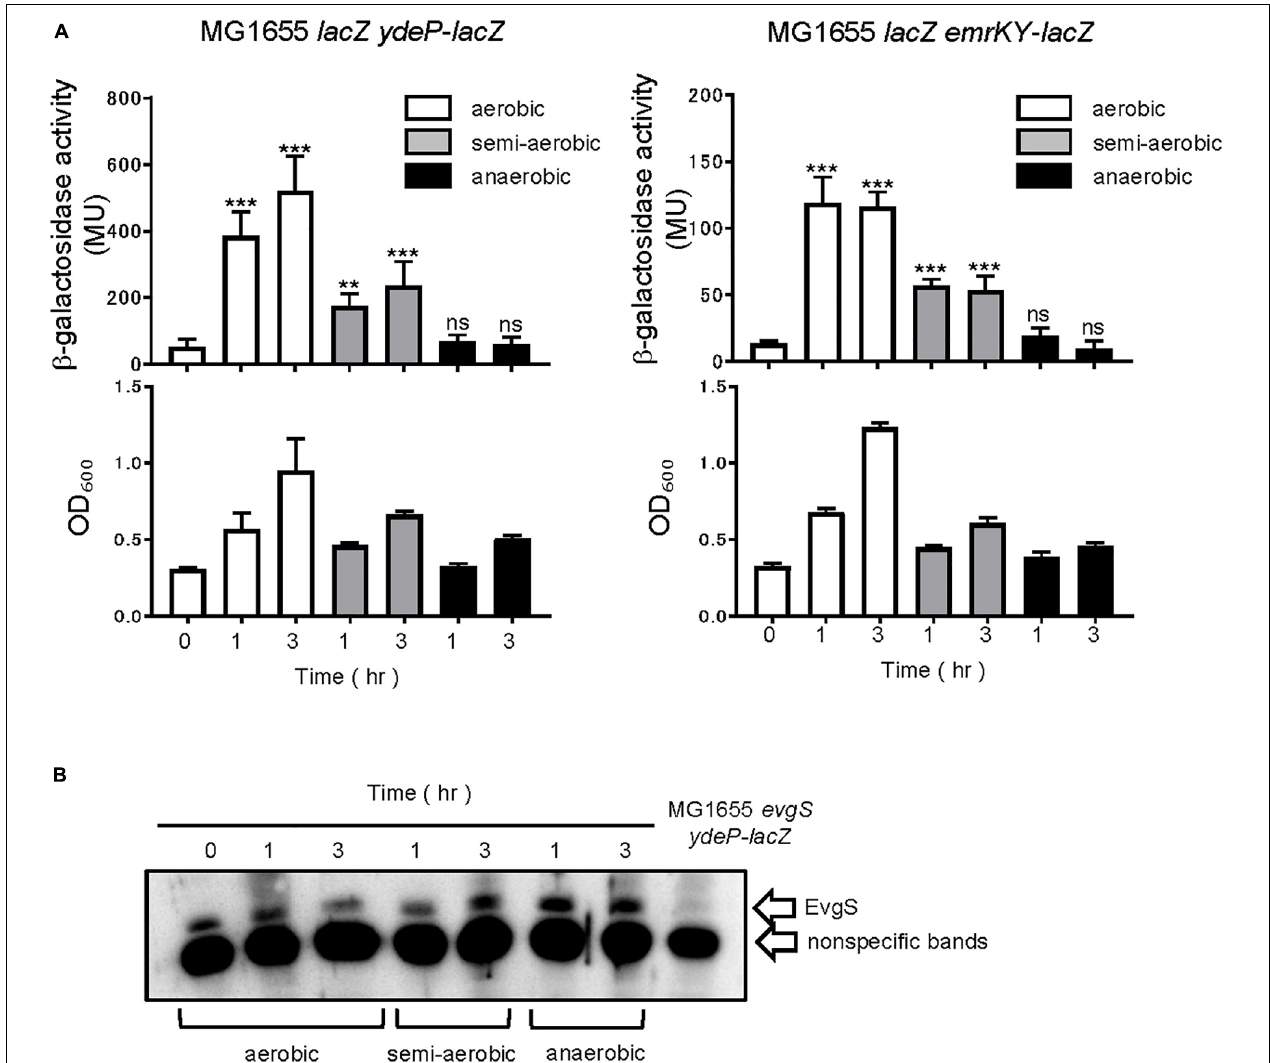
FIGURE 1 | Aeration is required for EvgS/EvgA activation. (A) Activity of the ydeP-lacZ and emrKY-lacZ reporters in different culturing conditions (upper panels). Cells were grown in EvgS-activation medium under aerobic (white bars), semi-aerobic (gray bars), or anaerobic condition (black bars) at 37 ◦ C. Cell growth indicated by optical density at 600 nm is shown in the lower panels. Data represent the average of three biologically independent replicates. Error bars indicate the standard deviation, and statistical analyses of each redox condition group were performed using Dunnett’s multiple comparison test with the time 0 sample as the control. ns, not significant; **0.001 ≤ p < 0.01; *** p < 0.001. (B) EvgS expression in MG1655 lacZ ydeP-lacZ . Immunoblotting analysis using anti-EvgS antiserum for EvgS detection is shown. Samples are from the same culture as those subjected to reporter assays. Lane at the right end shows the sample from an evgS deleted